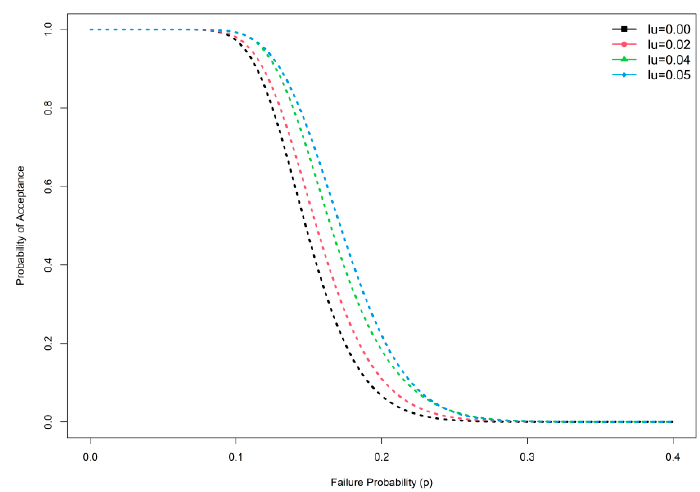
Figure 1. OC curve plan at different indeterminacy values.